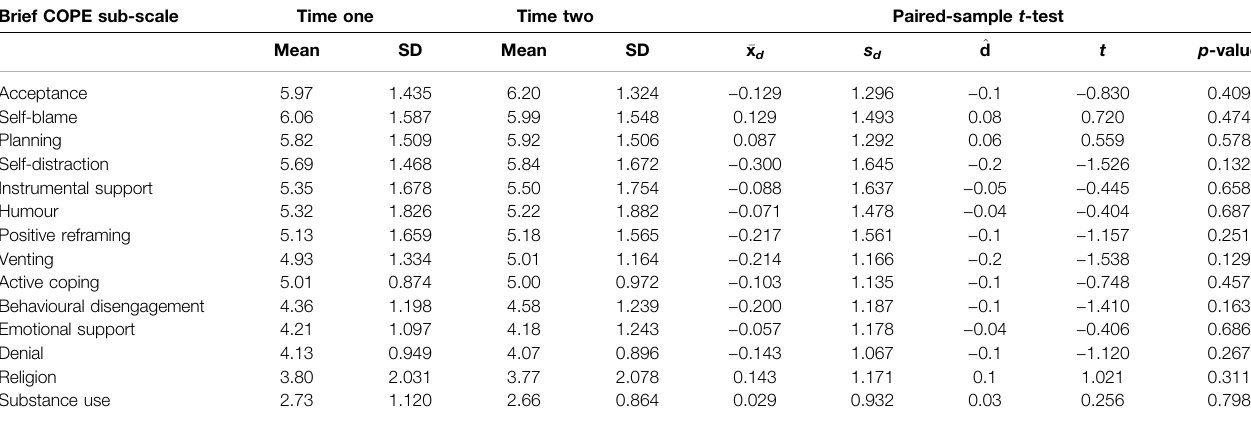
TABLE 8 | Brief COPE Scale Paired Sample t-test Results Summary a . Brief COPE